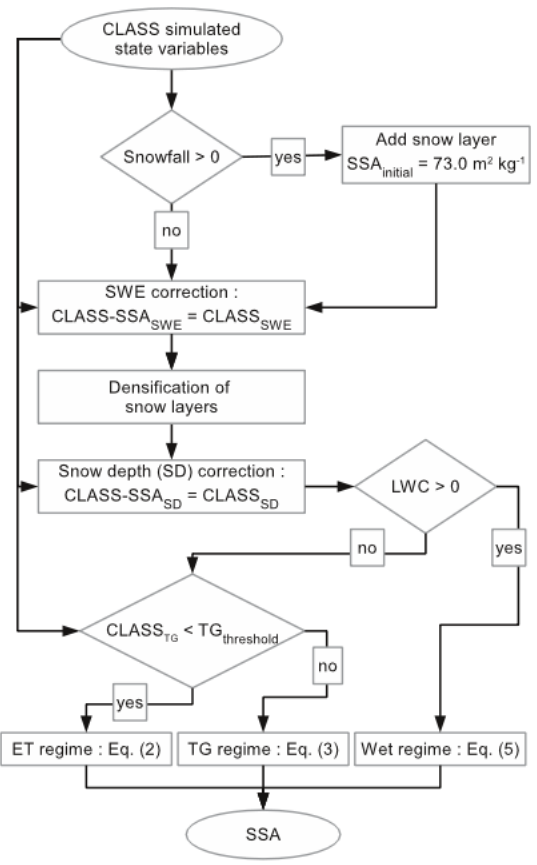
Fig. 1 : CLASS-SSA model flow chart 1094 1095 Fig. 1. CLASS-SSA model flow